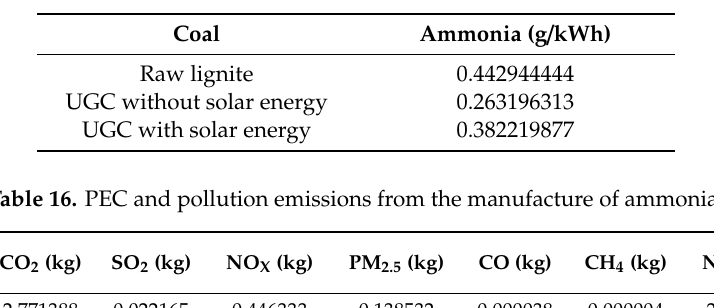
Table 15. Relationship between the amount of ammonia and electricity.